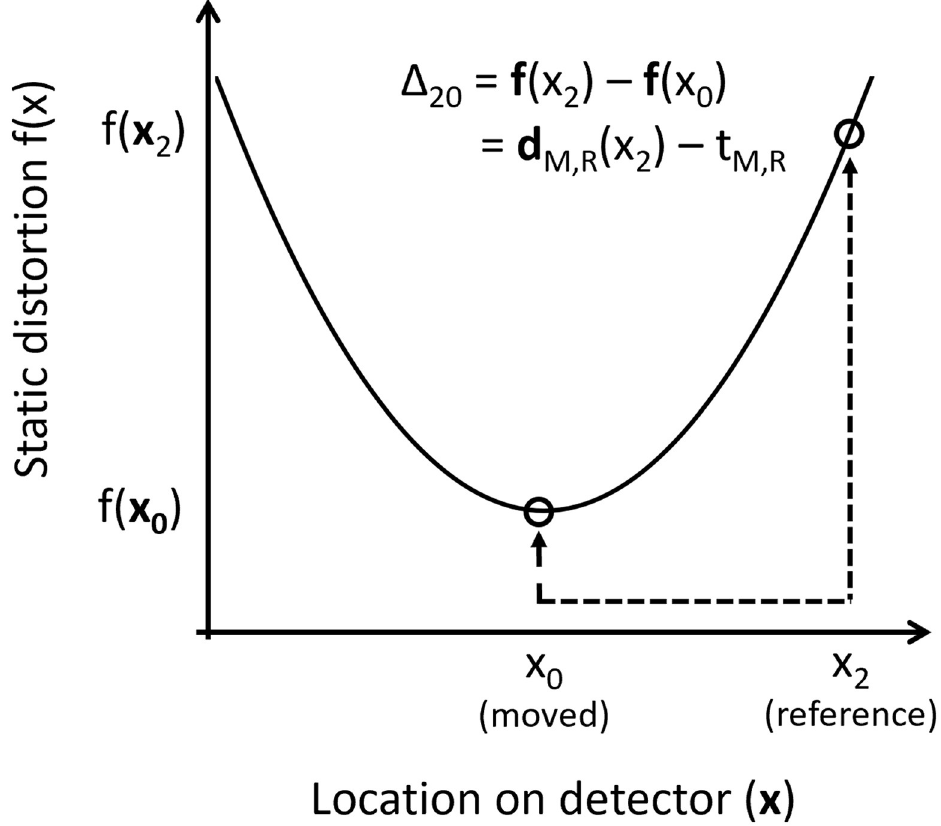
Fig 1. Illustration of a paired functional difference. An example static distortion map f(x) is defined over the pixels of the detector (x). Circles represent examples where detector pixels (x 0 in the moved image, x 2 in the reference image) were determined, by image registration, to have “seen” the same object in different frames as was depicted in Table 1. The value of the distorting function at the two locations is f(x 0 ), f(x 2 ). The object in question has shifted between moved and reference frames by an amount (d M,R ), which is equivalent to the sum of a) the difference in the distorting function f(x 2 ) − f(x 0 ), and b) the overall translation of the scene t M,R . Therefore, pixel-wise registration between shifted versions of the same scene can be used to build up information about the shape of the distorting function that is common to each